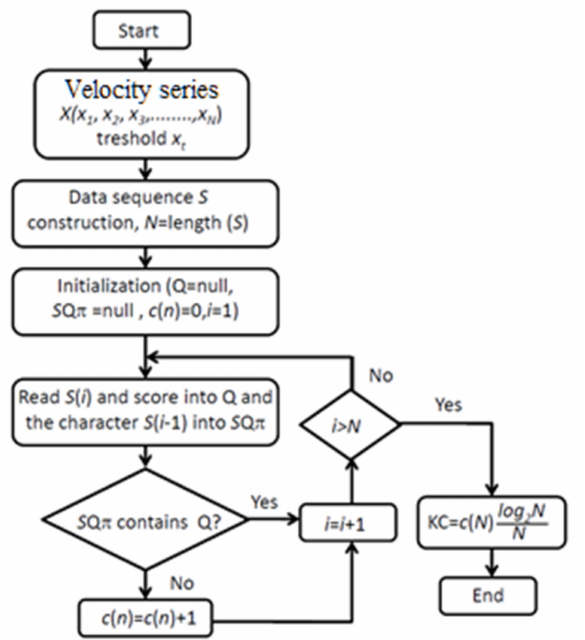
Figure 3. Flow chart for calculating the Kolmogorov complexity